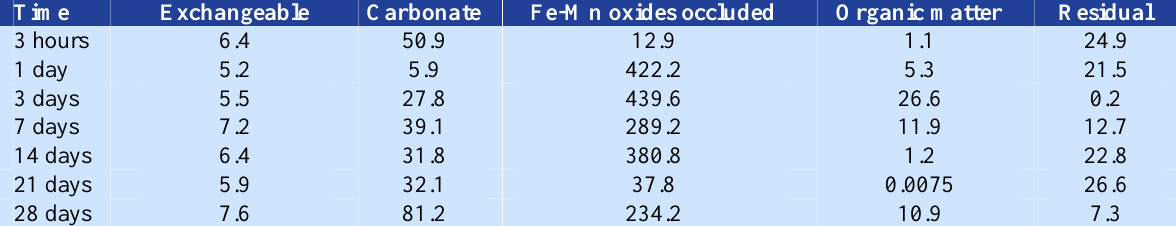
Table 7. Concentration (mg/ kg) of Zn in each fraction in the control soil Time